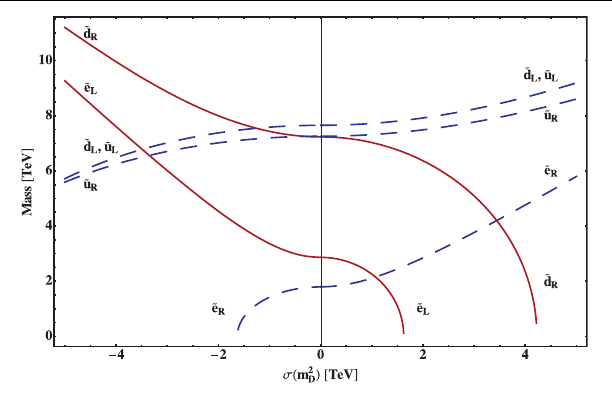
FIGURE 2 | First generation sfermion masses as a function of the SO(10) D-term σ parameters are fixed as in Equation. (9)